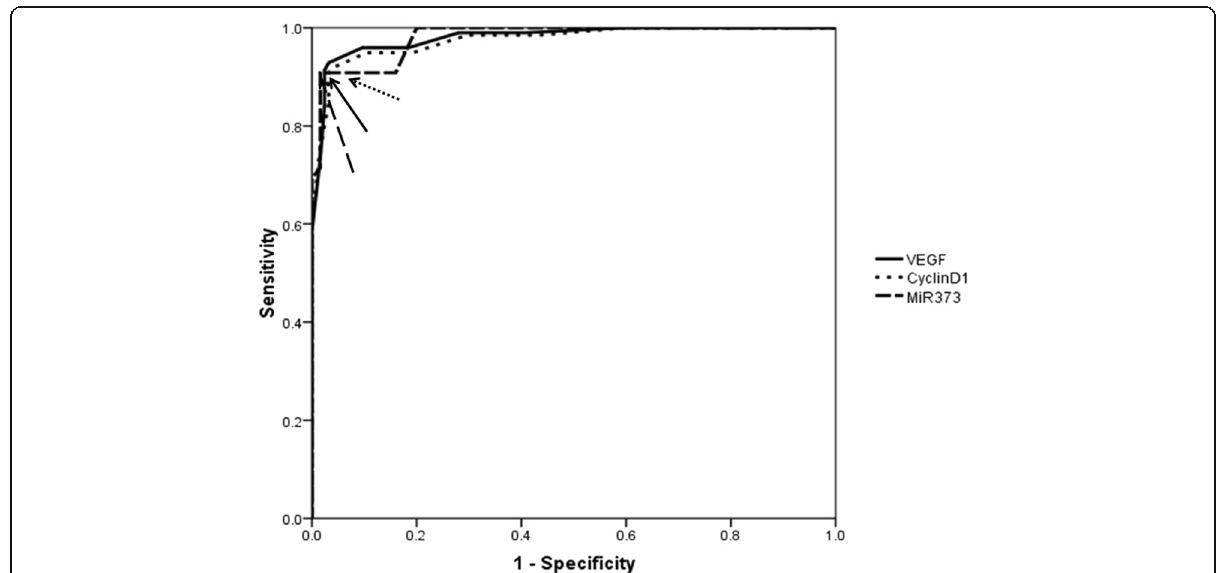
Fig. 1 Receiver operating characteristic curve for investigated markers. Arrows donate to the cut value for investigated markers: for VEGF, the cutoff was 38 ng/ml with sensitivity at 92.35% and specificity at 96.8% at standard error 0.0077 and CI% 0.955 – 0.991, area under the curve 0.978; for cyclin D1, the cutoff was 38 ng/ml with sensitivity at 91.8% and specificity at 96% at standard error 0.008 and CI% 0.952 – 0.989, area under the curve 0.975; and for miR-373, the cutoff was 360 ng/ml with sensitivity at 90.8% and specificity at 98.4% at standard error 0.007 and CI% 0.958 – 0.992, area under the curve